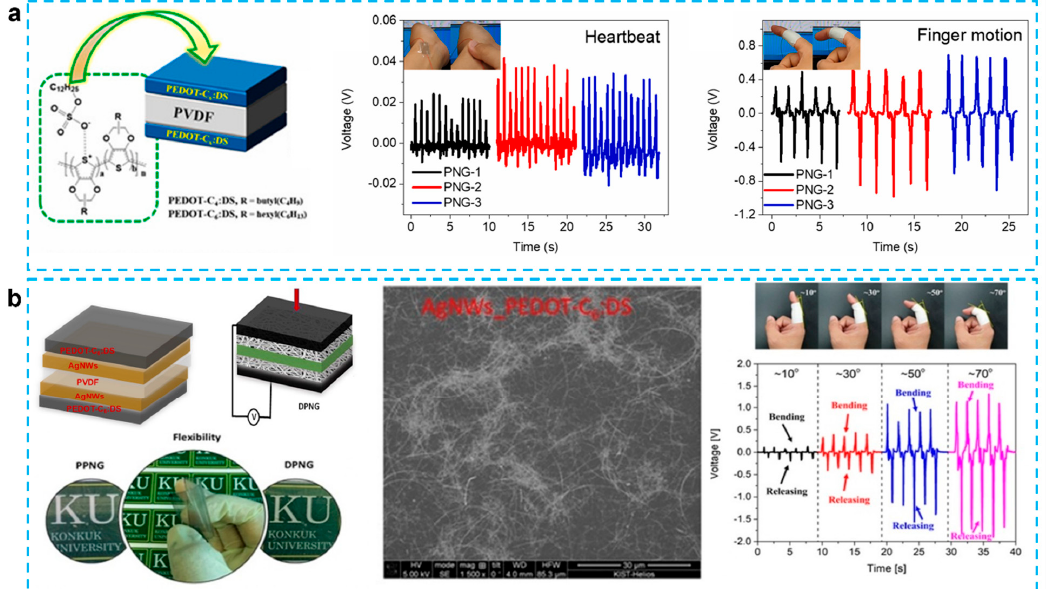
Figure 5. ( a ) Schematic illustration of sandwich structure with PEDOT-Cx:DS. The generated output voltage performance from the PNGs used for heartbeat monitoring system attached to wrist and human motion monitoring system attached to index finger [59]. ( b ) Schematics of DPNG, Photographs of transparency of AgNWs film, Flexible PVDF based hybrid electrode PNG and transparency of hybrid electrode, cross-section SEM images of DPNG, Performance of flexible DPNG under index finger movement [26].